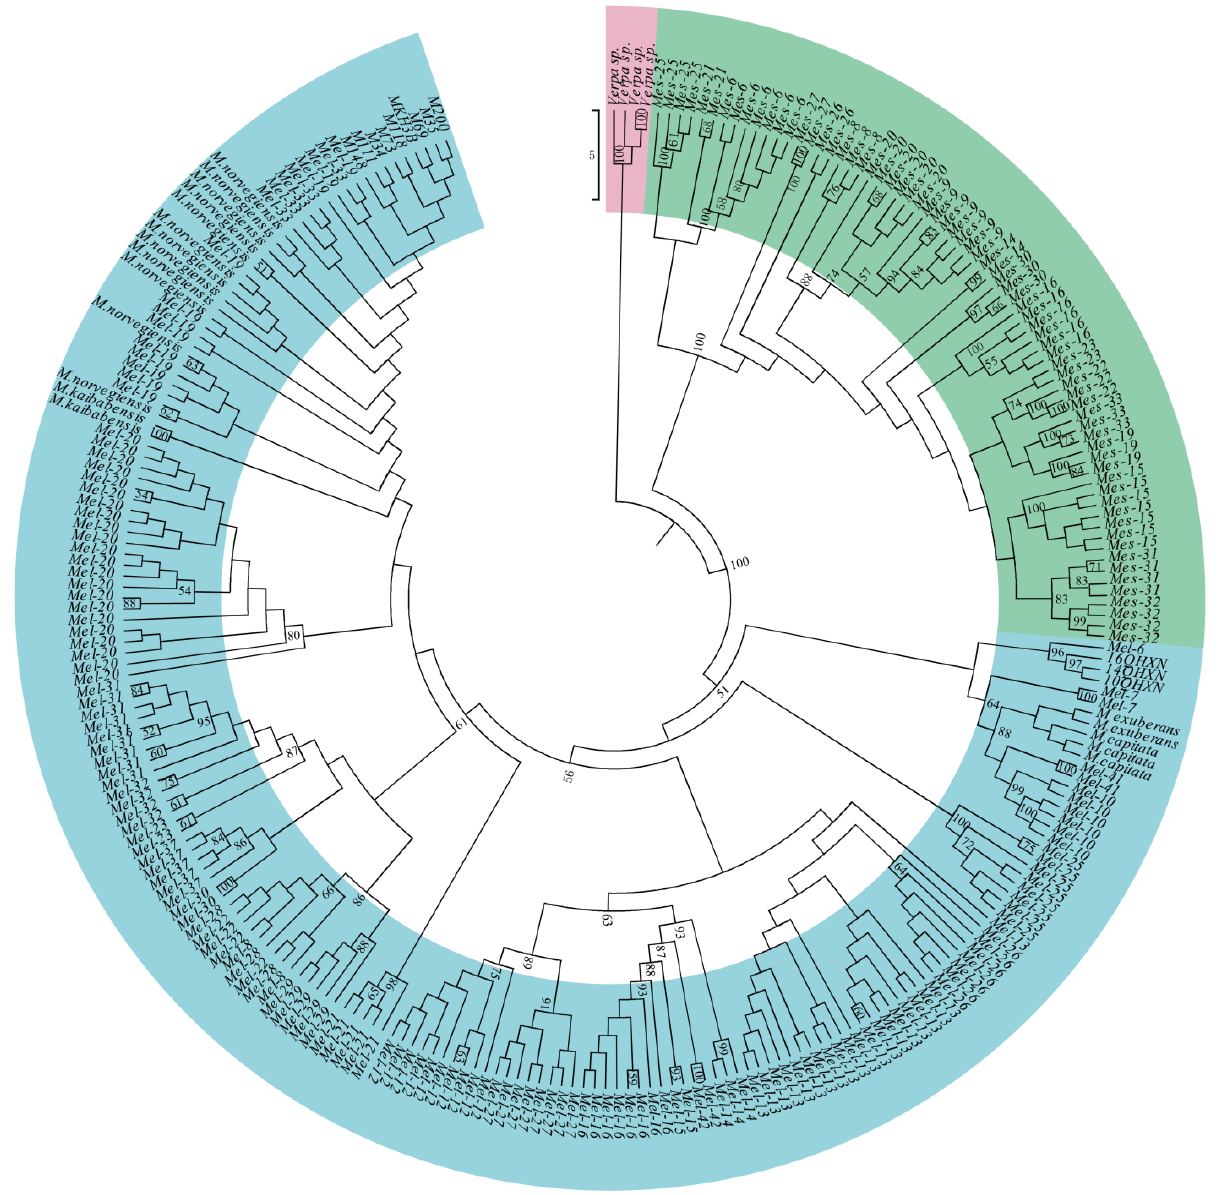
Figure 5. Maximum likelihood phylogenetic tree of Morchella based on the ITS, EF1- α , RPB1 and RPB2 data set. Bootstrap support values based on 1000 pseudoreplicates of the data (>50%) are indicated above each internode. Pink stands for the outgroup, green represents the Esculenta Clade, and blue is the Elata Clade.